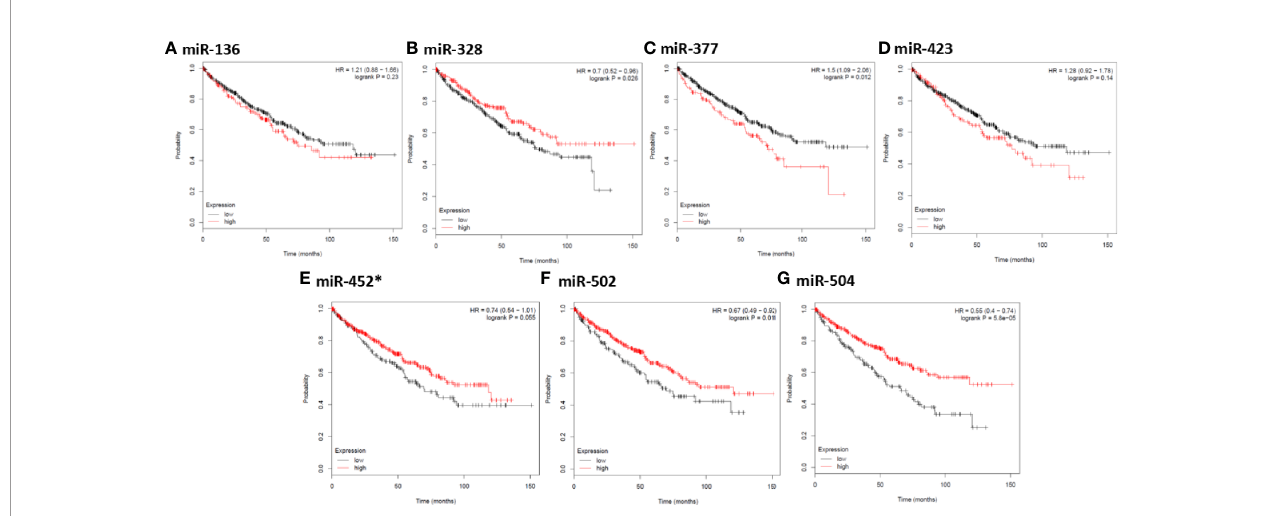
FIGURE 6 | Kaplan-Meier survival analysis for the correlation of seven down-regulated key miRNAs with overall survival of the patients with ccRCC. The vertical coordinate represents the survival probability of ccRCC patients. The red curve represents ccRCC patients with up-regulation of miRNAs, while the black curve represents ccRCC patients with down-regulation of miRNAs. * indicates